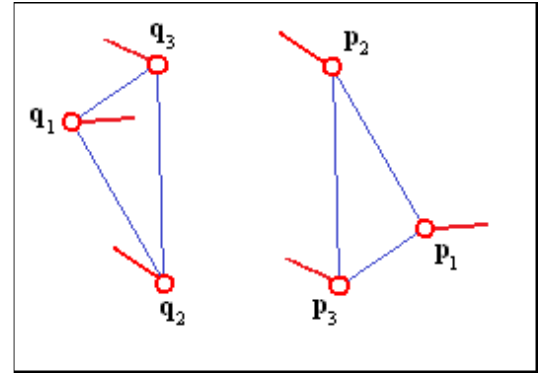
Figure 3. Minutiae triplets that do not match because minutiae pairs ( q ( q ; p ) highly differ in the directions of the minutiae relative to the sides of the 3 3